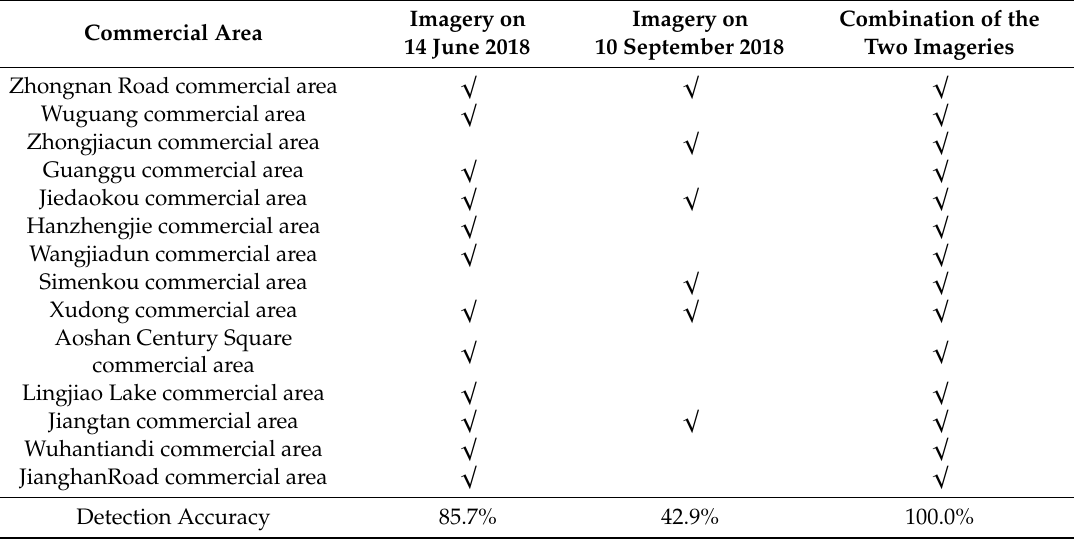
Table 4. Detection accuracy table of Wuhan’s imagery.